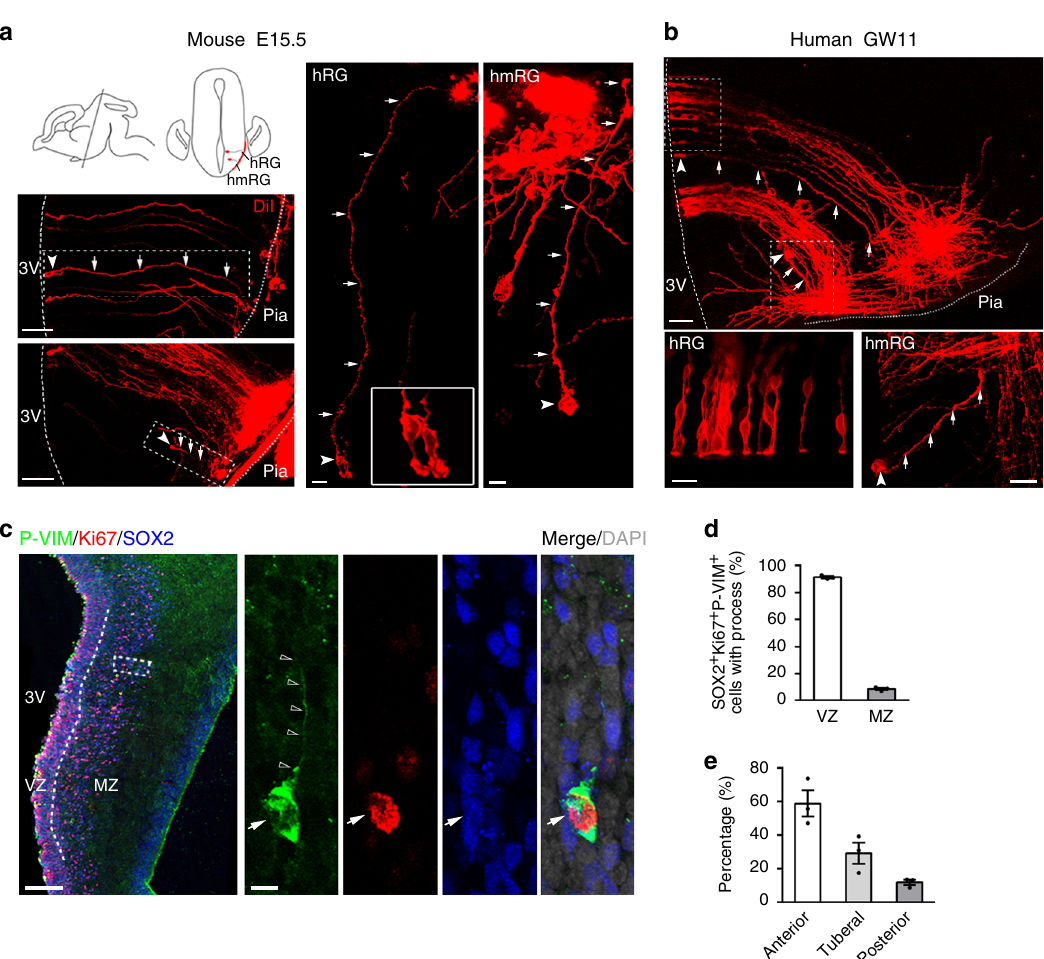
Fig. 1 Progenitor composition in the developing mammalian hypothalamus. a , b The mouse and human hypothalamic VZ and MZ are populated with radial glia and monopolar radial glia-like cells. The morphology of hypothalamic progenitors was labeled with DiI crystals on the pial surface. The insert shows dye diffusion along radial fi bers (arrow) from the hypothalamic pia terminating at distinct cell bodies (arrowhead) in the MZ or along the radial fi bers traversing to the radial glia cells in the VZ at E15.5 in mice ( a , n = 6 independent experiments) and GW11 in humans ( b , n = 3 independent experiments). Dashed lines indicate the surface of the third ventricle. Dotted lines indicate the pial surface. 3V, the third ventricle. Scale bars, 100 µ m (left, top and bottom), 20 µ m (middle), 10 µ m (right) in a , 50 µ m (top) and 20 µ m (bottom) in b . c P-VIM + (green) hmRG cells in the GW10 human hypothalamus were stained for SOX2 (blue) and Ki67 (red). High-magni fi cation images of the representative outlined cell are shown in the right panels. Arrows indicate hmRG cells that co-expressed Ki67 (red) and SOX2 (blue). Open arrowheads indicate the basal processes. Scale bars, 200 μ m (left) and 10 μ m (right). d Quanti fi cation of the percentage of RG cells identi fi ed by SOX2 + Ki67 + P-VIM + immunostaining in the VZ and MZ ( n = 3